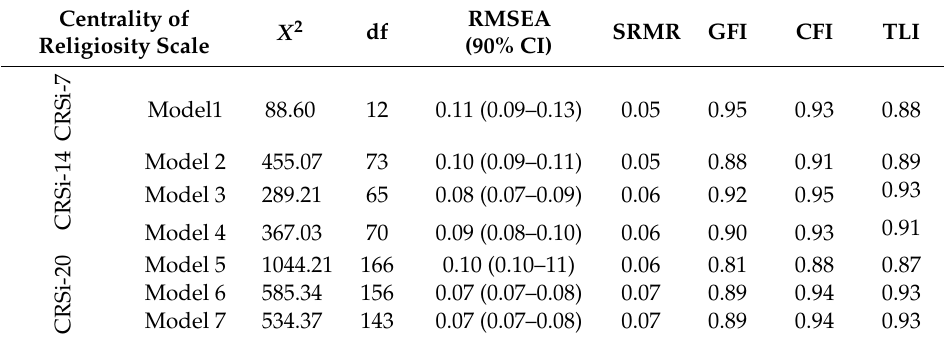
Table 3. Measures of Goodness of Fit Indices for all Seven